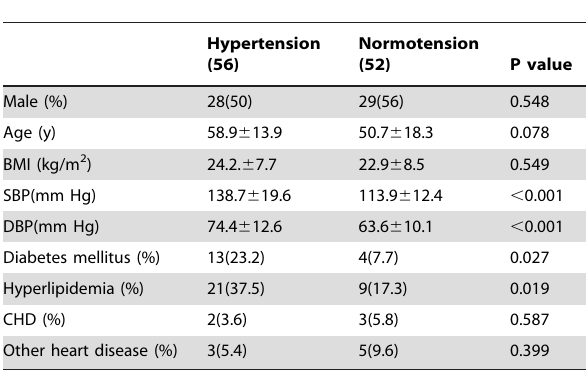
Table 1. The characteristics of two groups with either hypertension or